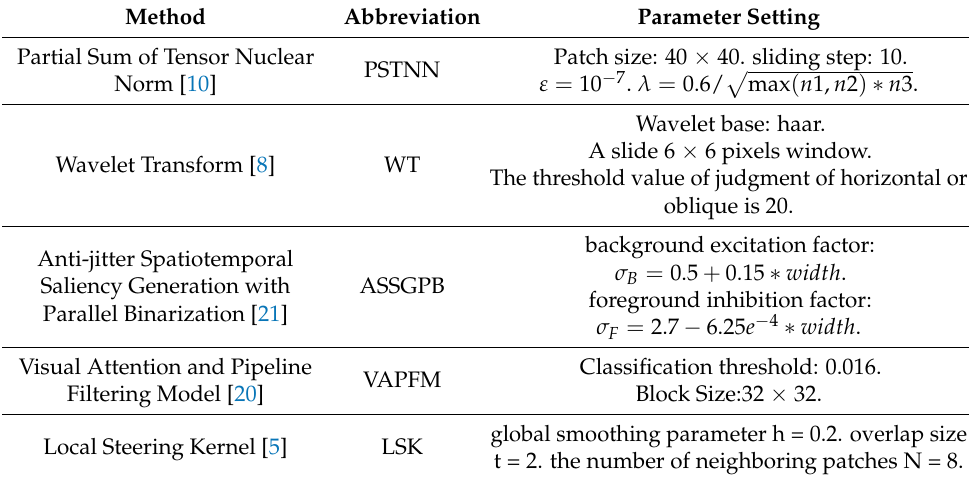
Table 1. Parameter setting of state-of-art